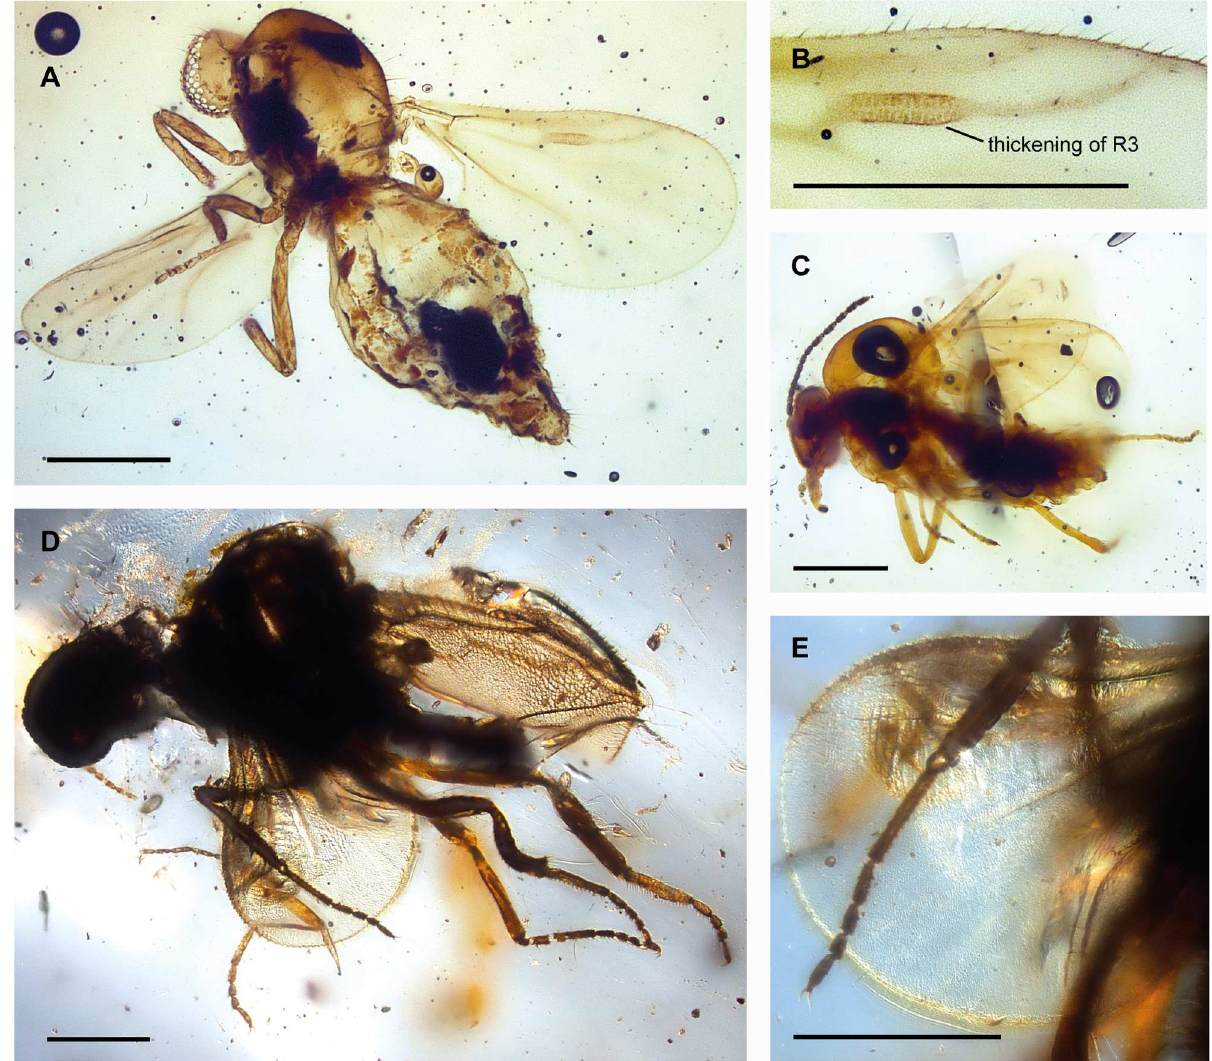
Fig 2. Females of Gedanohelea gerdesorum n. sp. and Eohelea indica n. sp. from early Eocene Cambay amber. A . Habitus of G . gerdesorum ,holotype no. Tad-857. B . Radialsector of G . gerdesorum with thickeningof radial vein R 3 , holotypeno. Tad-857. C . Habitusof G . gerdesorum ,paratypeno. Tad-513. D . Habitus of Eoheleaindica , holotypeno. Tad-855. E . Left wing and mid leg of Eoheleaindica , holotype no. Tad-855. Scale bars: 0.2